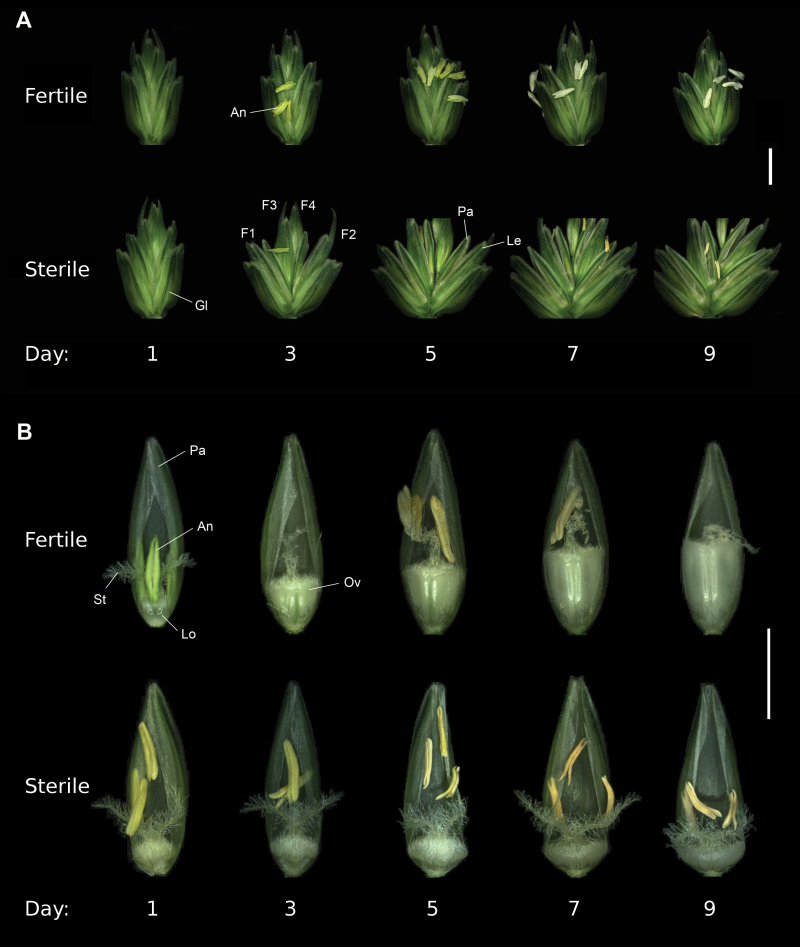
Spikelet and floret images of male-fertile and male-sterile plants during flowering time and early seed development. For sample staging, days were counted from full heading (spike completely emerged from the flag leaf), with the day of full heading being Day 1 (1 DF). (A) Spikelet of male-fertile (Ms5, top) and male-sterile (ms5, bottom) plants. (B) Floret of male-fertile (Ms5, top) and male-sterile (ms5, bottom) plants. Abbreviations: An, anther; F1–F4, floret number 1–4; Gl, glume; Le, lemma; Lo, lodicule; Pa, palea; Ov, ovary; St, stigma. Scale bars in (A) and (B) are 5 mm and 2 mm, respectively.